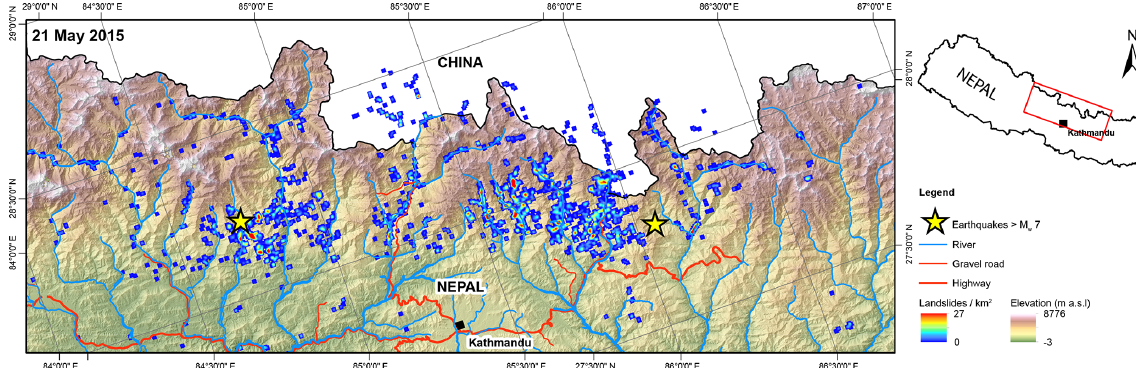
Figure 5. Extract from map released on 21 May, 9 days after the Dolakha earthquake. Due to cloud cover and image acquisition, this map did not include landslides that occurred following the Dolakha